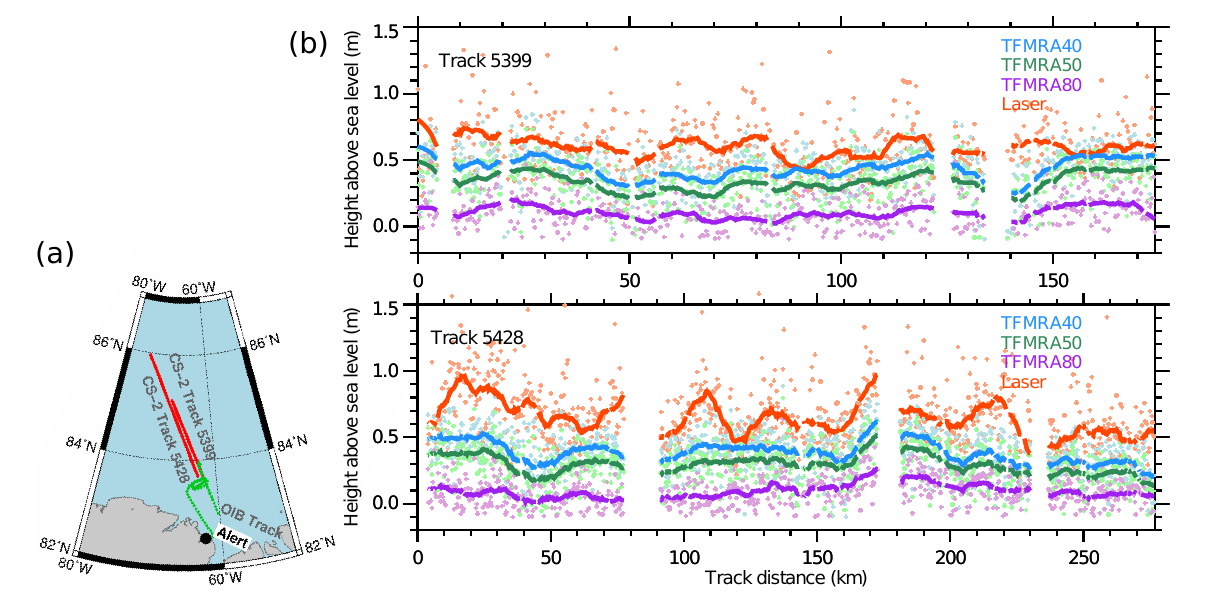
Figure 7. (a) Area of coincident flights of CryoSat-2 (CS-2) and Polar-5 (black box in Fig. 6) from 15 and 17 April 2011. The green dotted line shows the track of Operation IceBridge (OIB) flight 1038 that carried a snow-depth radar. The aircraft surveyed the ascending CryoSat-2 tracks from the southeast to the northwest. (b) Uncorrected TFMRA40, TFMRA50 and TFMRA80 radar freeboard of CryoSat-2 and snow freeboard from airborne laser altimetry (“Laser”) along CryoSat-2 tracks 5399 and 5428. For the comparison only valid data from coincident coverage are considered. The dots represent the original data with a spatial resolution of 300m. We additionally applied a running mean (10km width, solid lines).